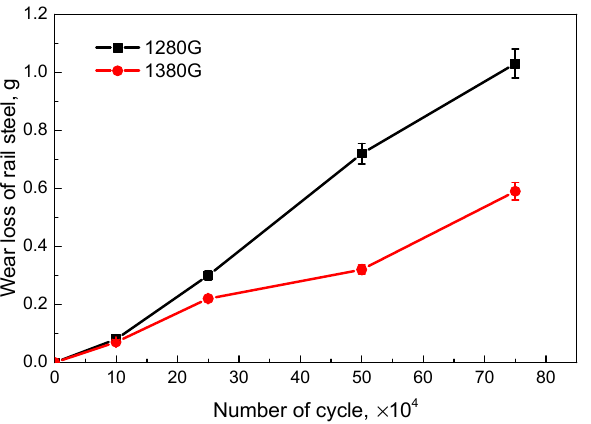
Figure 7. Change of wear mass loss of 1280G and 1380G rail steels with rolling